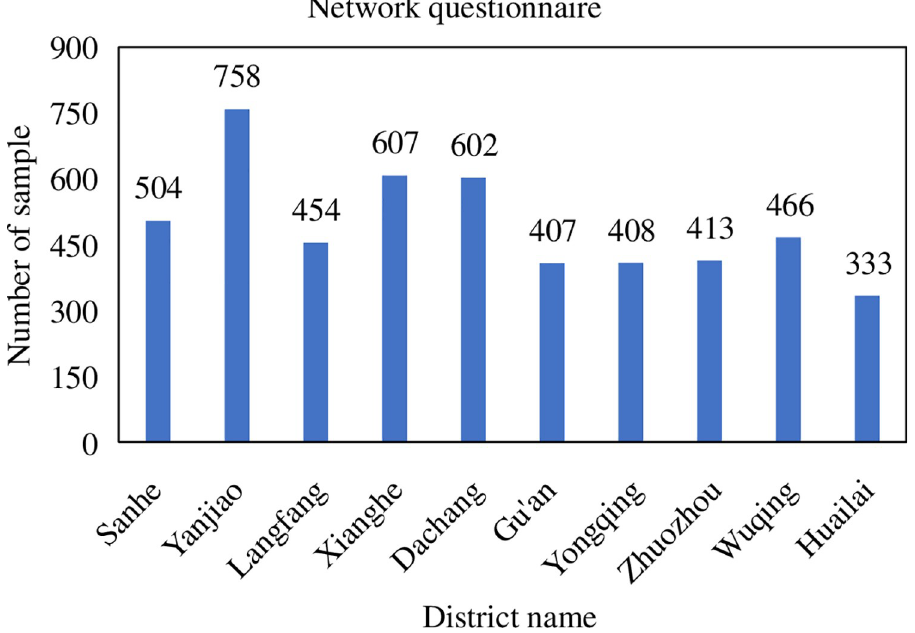
Fig 3. Survey sample size—online